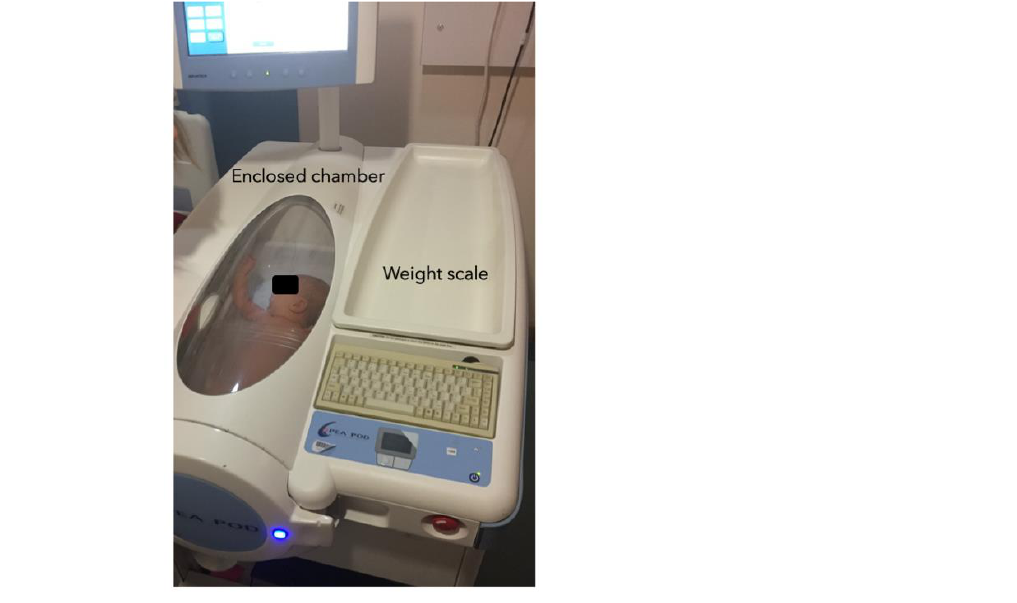
Figure 2. Infant body composition measurement using ADP-Pea Pod in CBGS-BF .